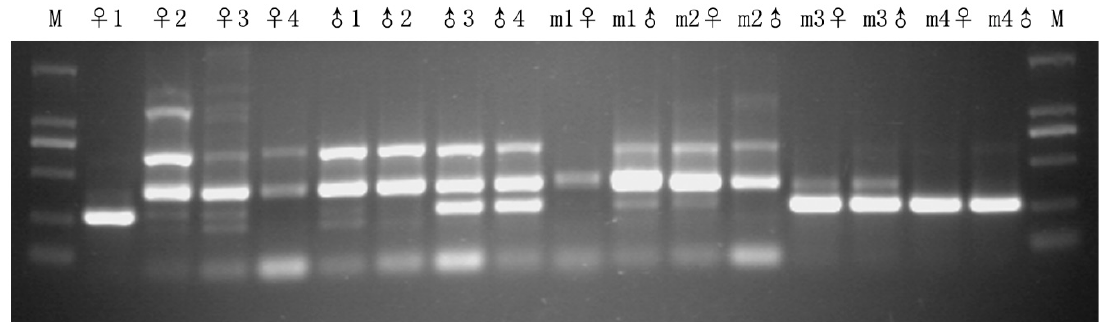
Figure 2. Polymerase Chain Reaction (PCR) banding patterns of DNA samples from four female, male, and monoecious Pistacia chinensis using E5-F/R sequence-characterized amplified region (SCAR) primers.